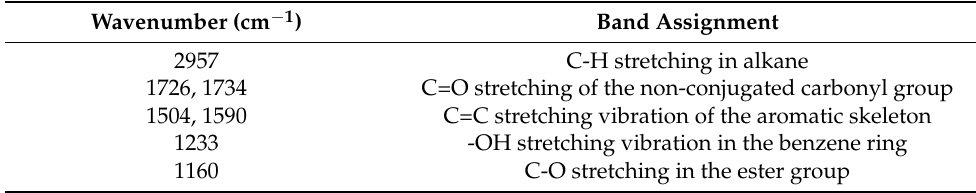
wood before and after UV